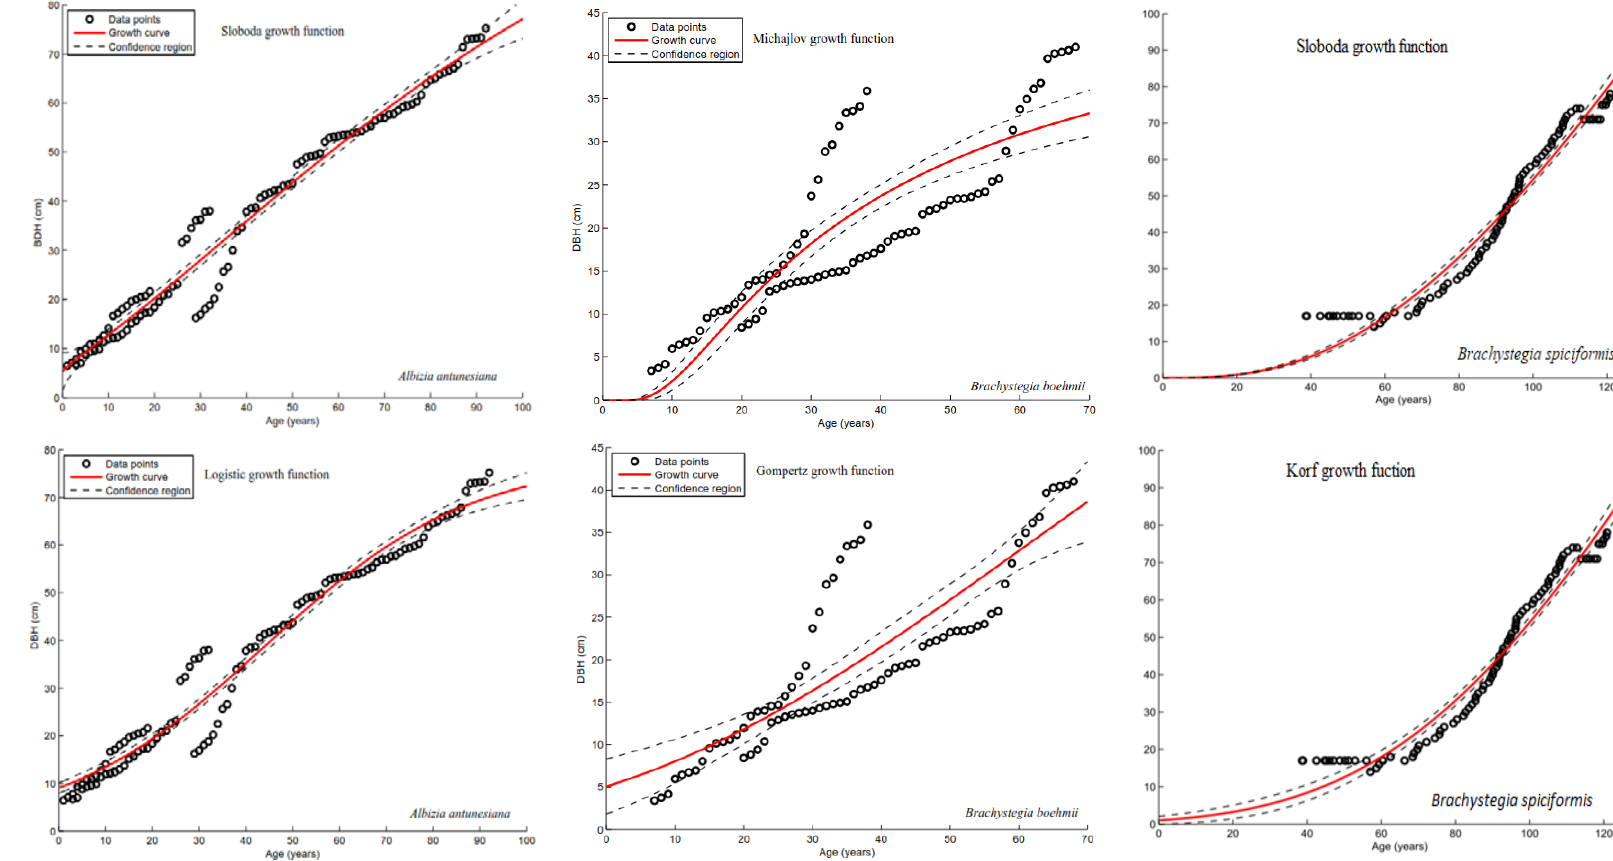
Figure 6. Illustration of time required for individual trees to reach DBH by different models.